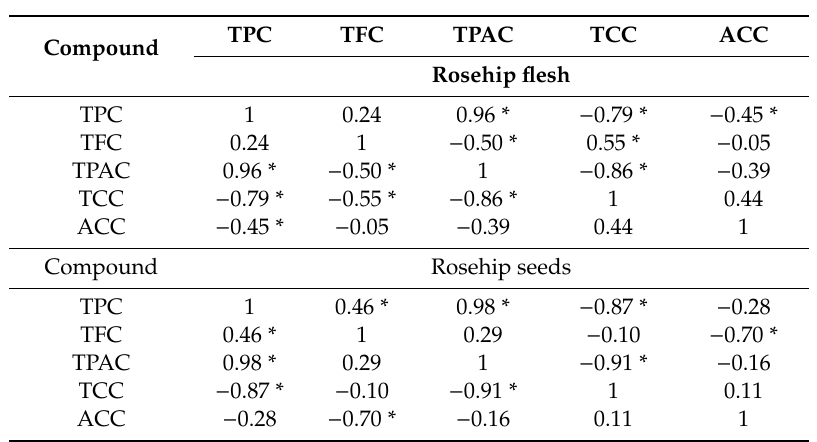
Table 4. Correlations between biologically active compounds content in di ff erent organic rosehip flesh and